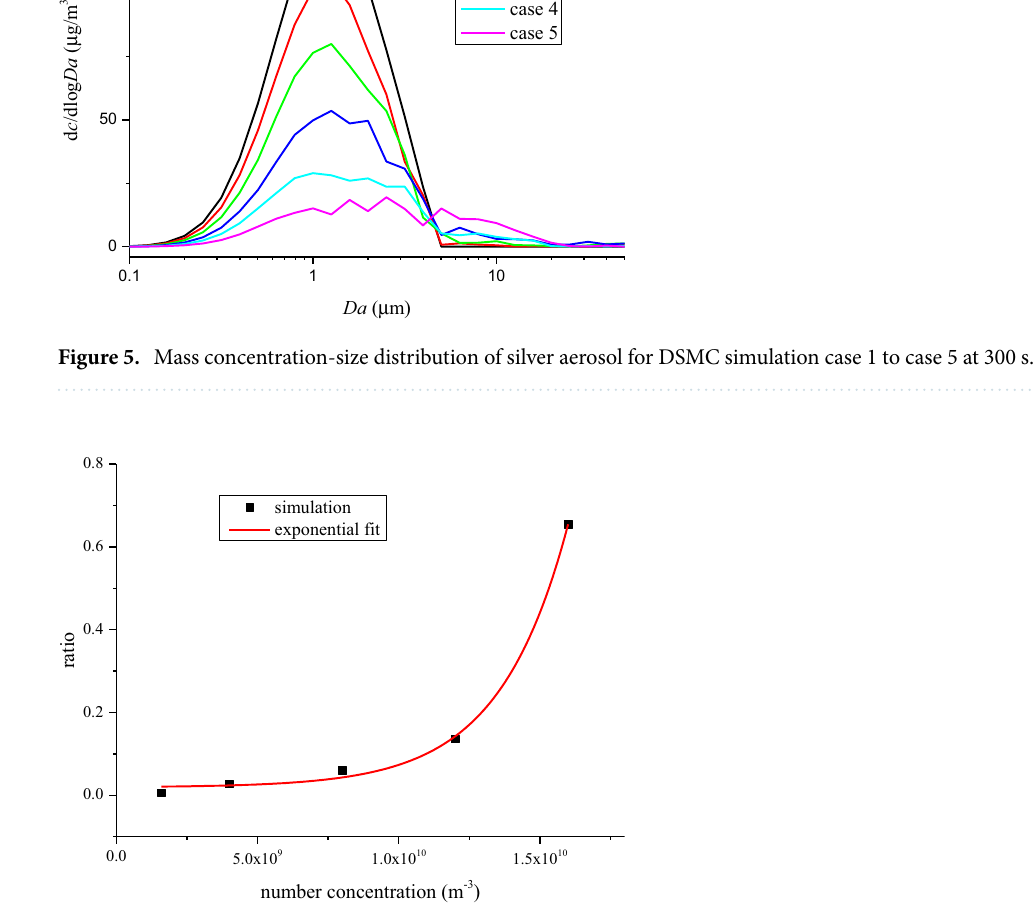
Figure 6. Ratio of mass concentration-size distribution of silver aerosol between 10 and 1.1 µm, versus the total number concentration of HE products and rust aerosols. An exponential fit is applied and presented by red line, which shows a clear exponential increase tendency of the data